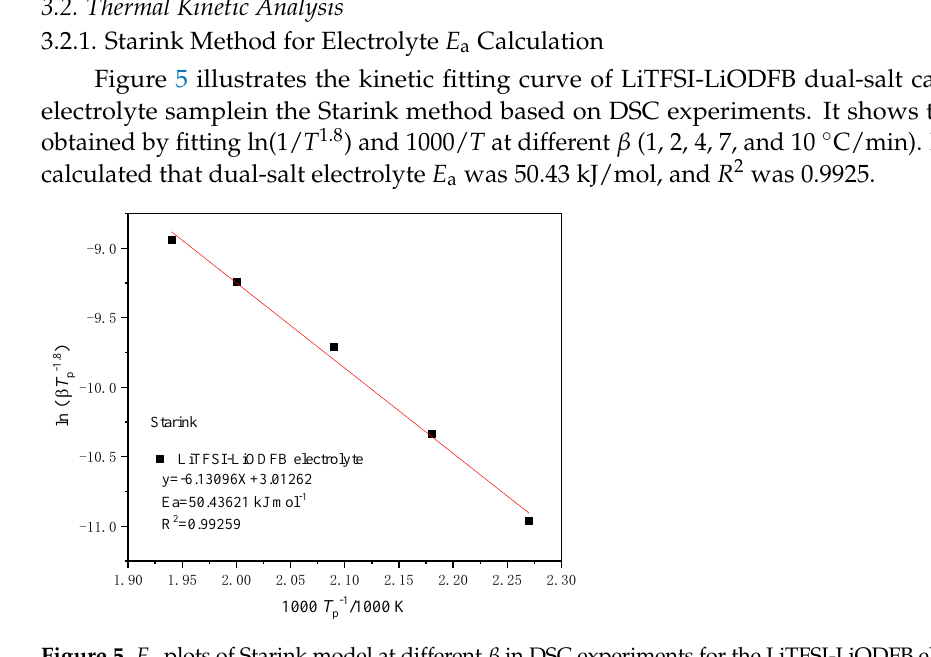
Figure 5. E a plots of Starink model at different β in DSC experiments for the LiTFSI-LiODFB elec- trolyte.